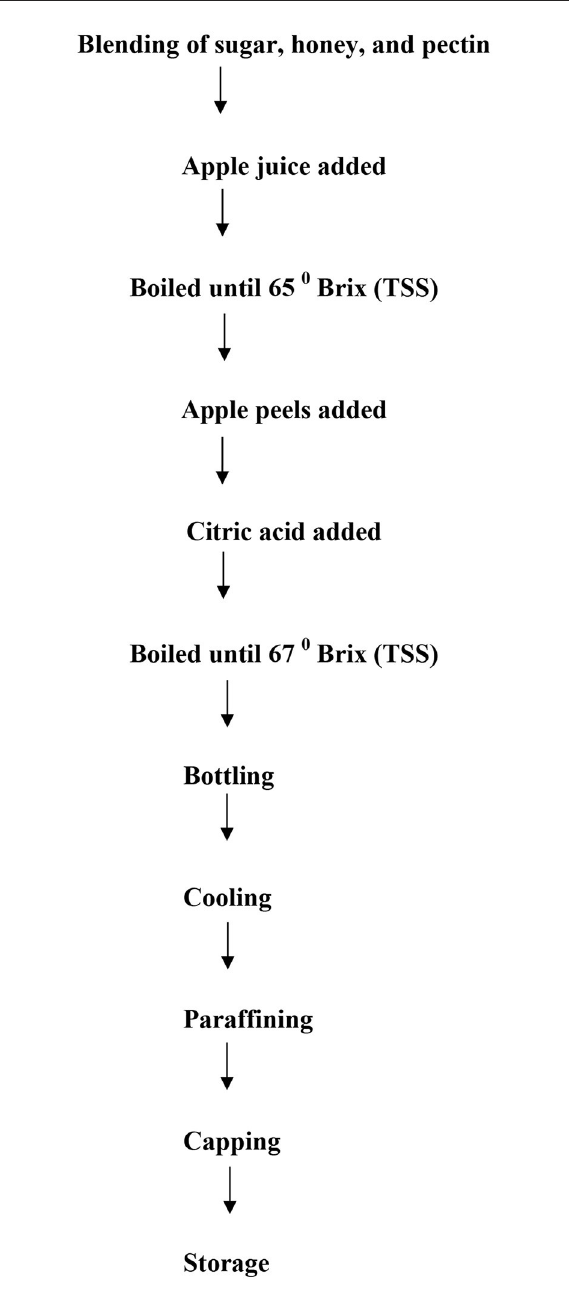
FIGURE2 Flow chart for the preparation of honey-based apple